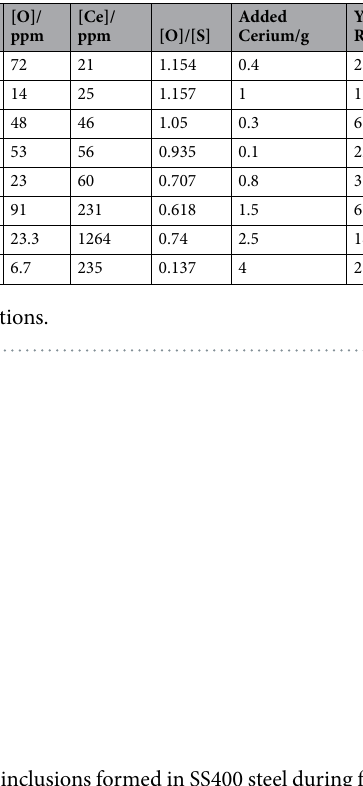
Table 2. Results of thermodynamic calculations for the main inclusions formed in SS400 steel during furnace- cooling from 1873 K to room temperature and Quenching from 1673